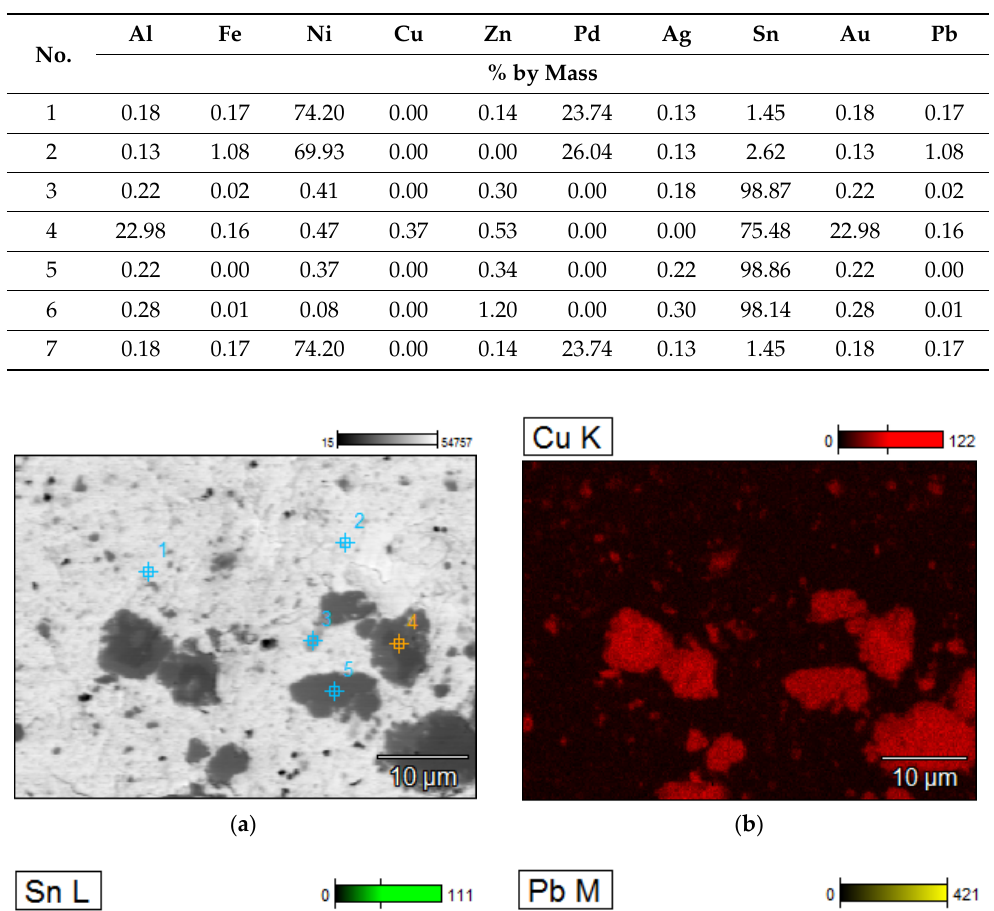
Table 10. Point and area chemical compositions of the lead ingots after melting with PCB pyrolyzate